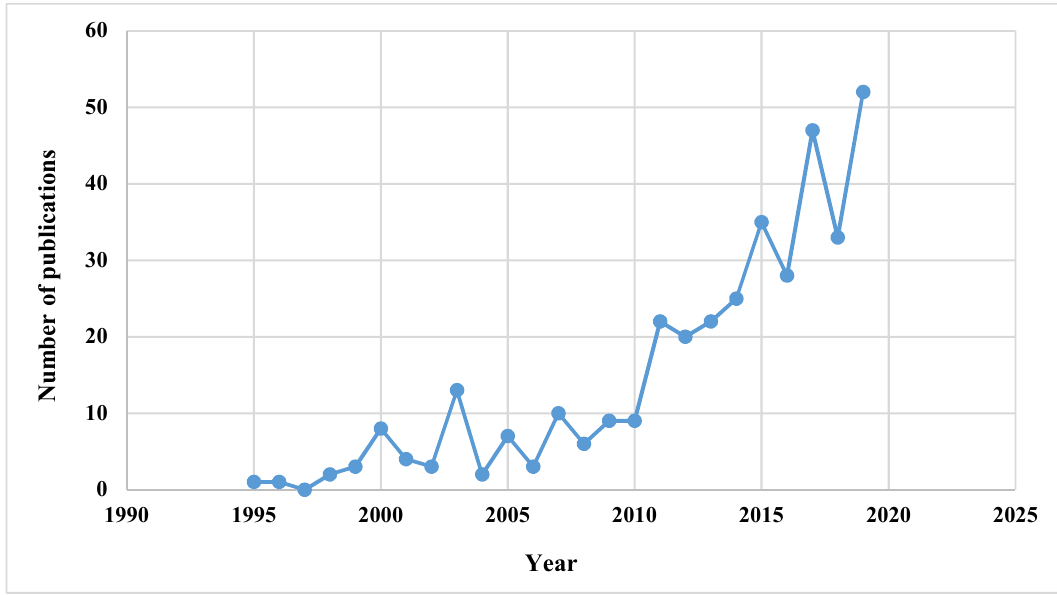
Figure 1. Increase in the number of publications in the field of pulsed light.